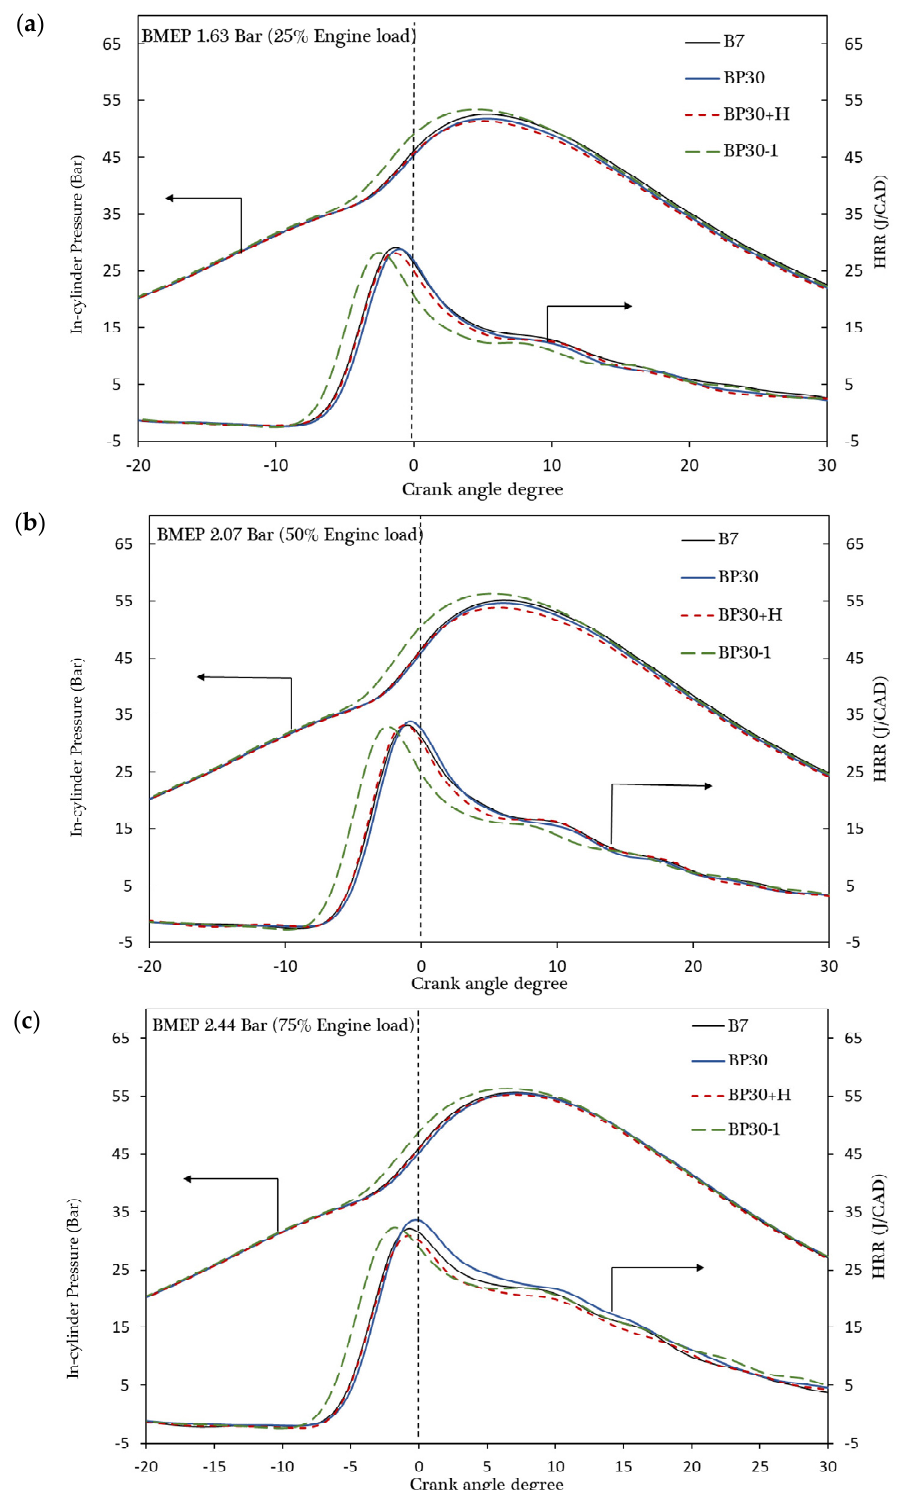
Figure 9. In-cylinder pressure profile and heat release rate in the combustion enhancement process with ( a ) a BMEP of 1.63 bar (25% engine load); ( b ) a BMEP of 2.07 bar (50% engine load); and ( c ) a BMEP of 2.44 bar (75% engine load).